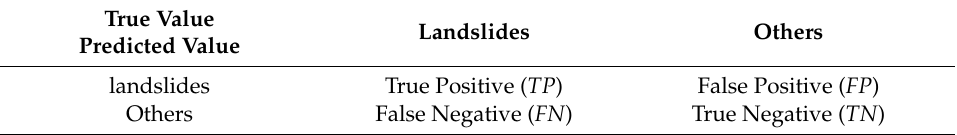
Table 1. Confusion matrix between predicted value and true